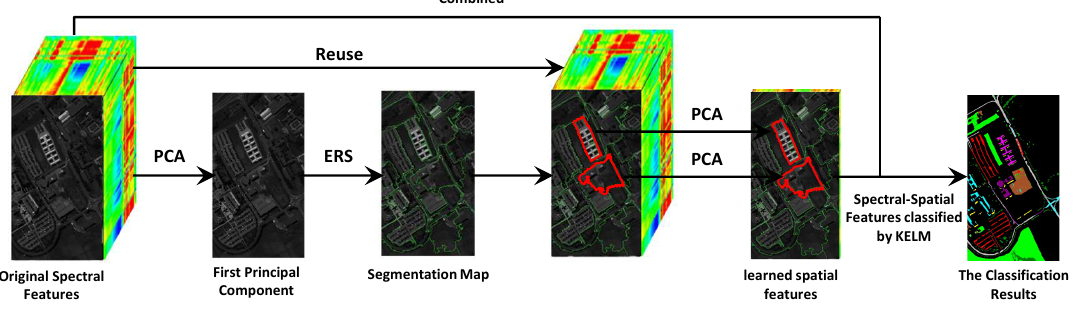
Figure 2. Schematic of the proposed SP-KELM method for HSIs.